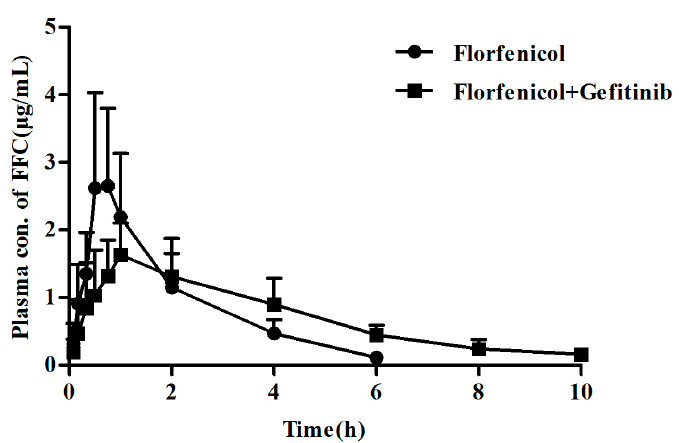
Figure 6. The plasma concentration-time profiles of orally administered florfenicol (20 mg/kg b.w.) in the presence and absence of gefitinib (100 mg/kg). Data represent mean ± SD ( n = 5).